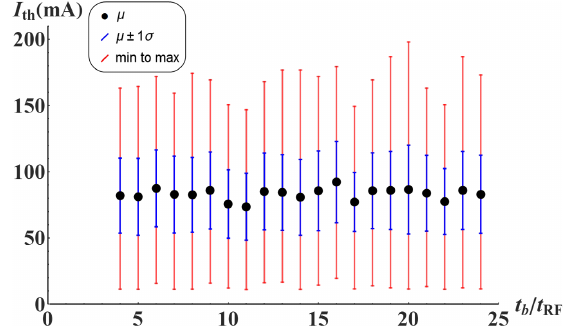
FIG. 8. I vs. t b =t for the CBETA 4-pass lattice. For each th rf t =t , 500 simulations are run with different HOM assignments b rf ( ϵ ¼ 125 μ m). The black dot marks the average I inner line marks the (cid:1) 1 σ range. The red outer line marks the range of the entire distribution.